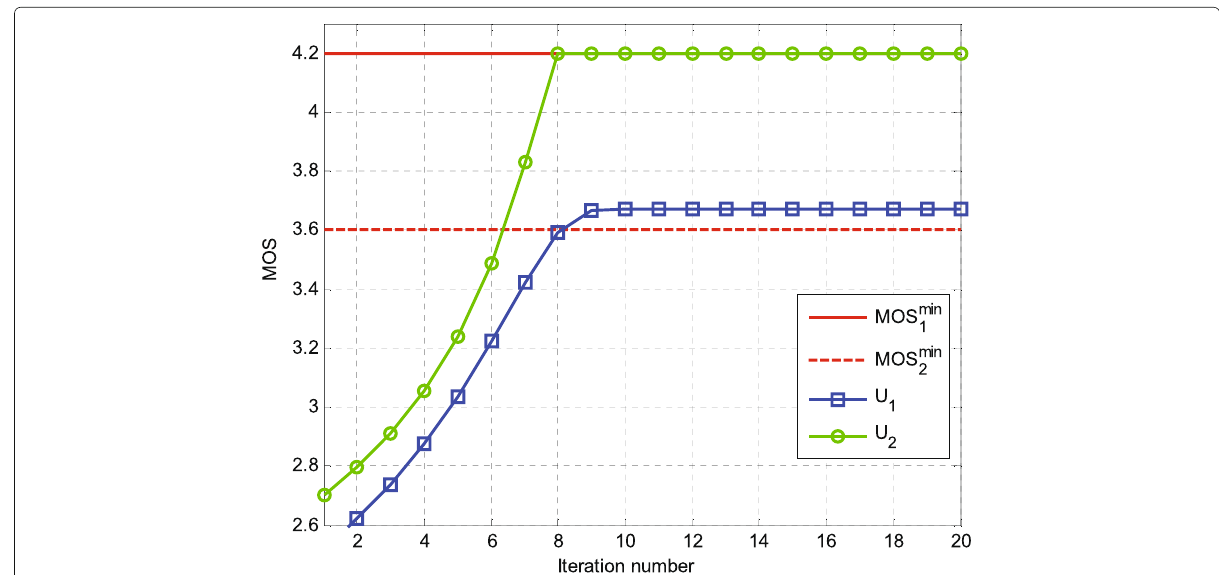
number increases to some extent, the growth of QoEW becomes slowly because of the limitation of the interfer- ence